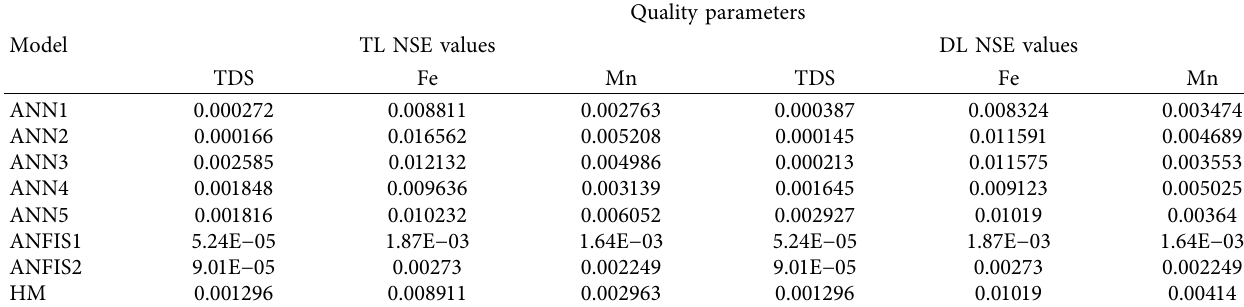
Table 7: MSE values for DL and TL ANN Models.